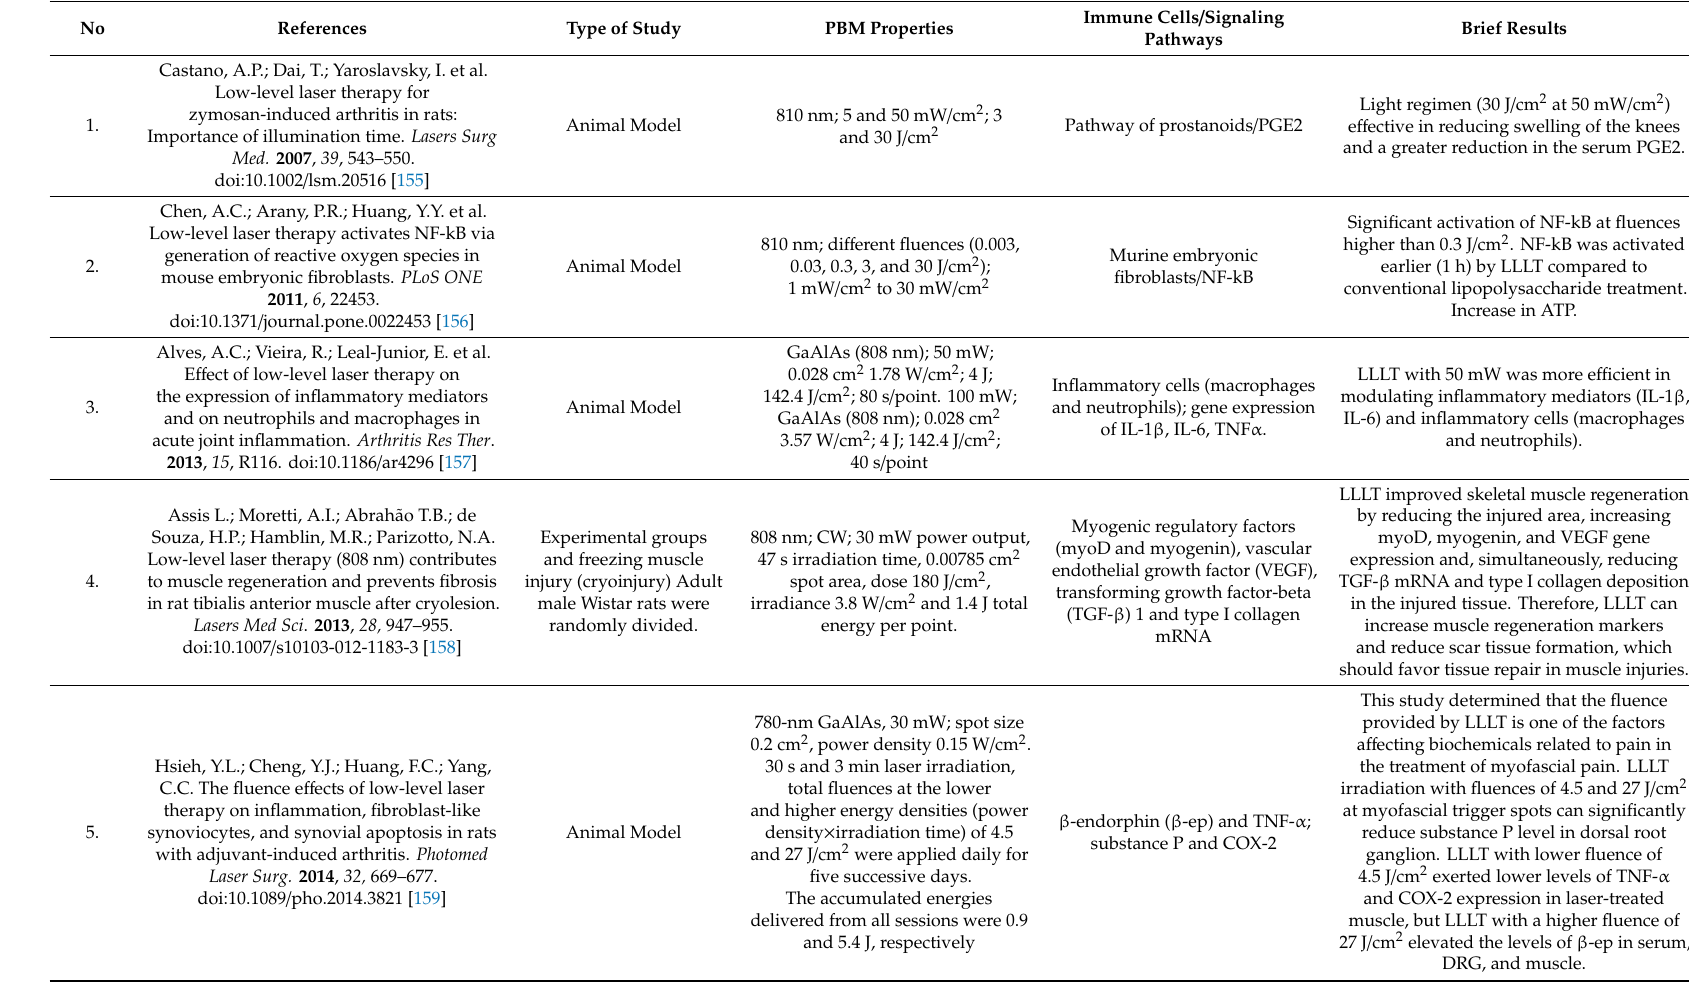
Table 1. Experimental photobiomodulation (PBM) studies applied to immune cells and signaling pathways. IL: interleukin, LLLT: low-level laser therapy, MMP: matrix metalloproteinases, NF-kB: nuclear factor kappa-B, TNF- α : tumor necrosis factor